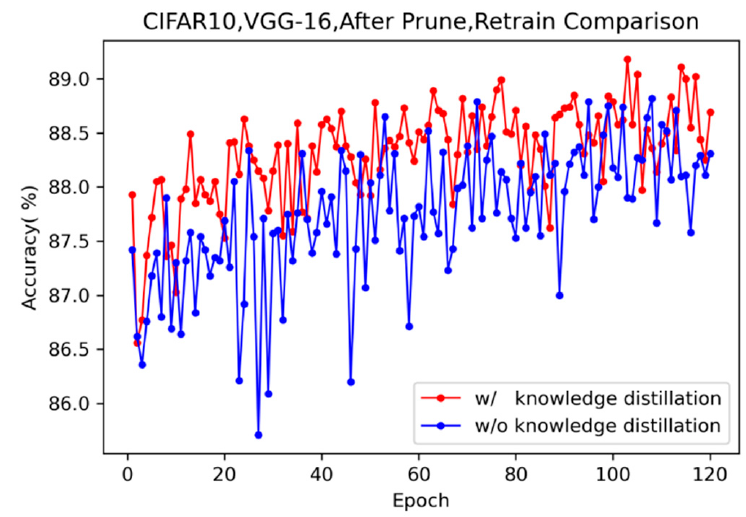
Figure 10. Long-term training results.